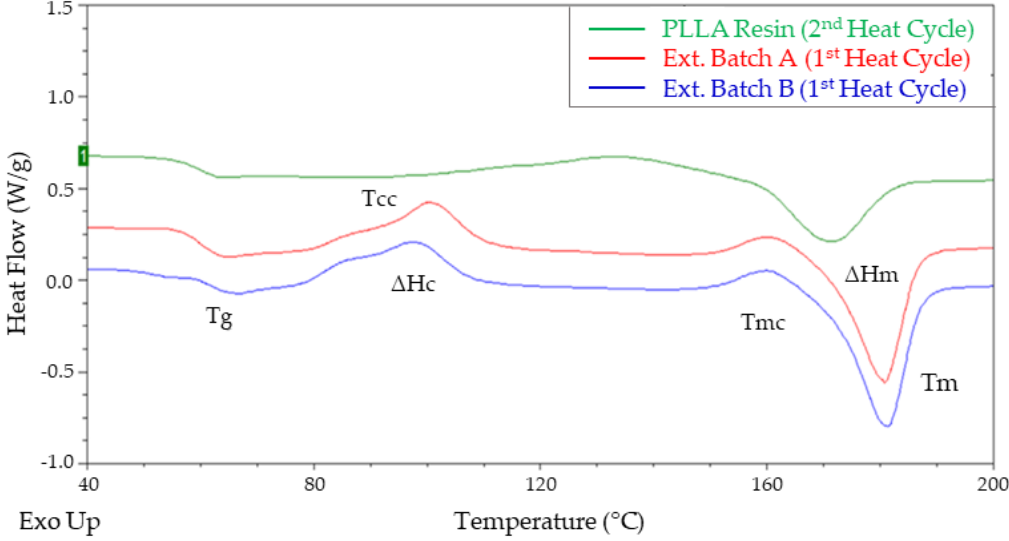
Figure 8. DSCcurveoverlayofPLLAresinandextrudedBatchA&Bplots. Abbreviations: T g : glasstransition Figure 8. DSC curve overlay of PLLA resin and extruded Batch A & B plots. Abbreviations: T g : glass temperature;T cc : coldcrystallisation; ∆ H c : enthalpyofcoldcrystallisation;T mc : meltrecrystallisation;T m :melt transition temperature; T cc : cold crystallisation; ΔH c : enthalpy of cold crystallisation; T mc : melt temperature; ∆ H m : enthalpy of melting; X c : degree of recrystallisation; T m : melt temperature; ΔH m : enthalpy of melting; X c : degree of crystallinity.